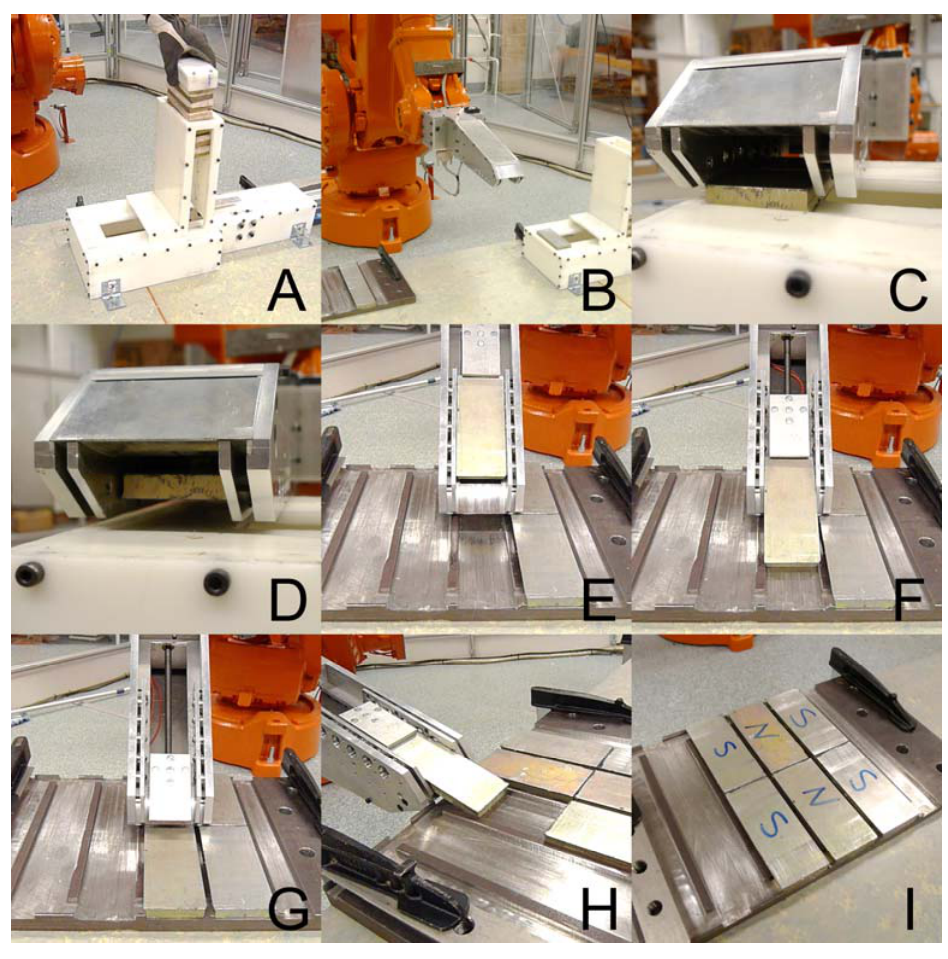
Figure 7. The full assembly process performed with the prototype robot cell: the PM delivery station is manually loaded ( A ); the PM mounting robot tool is turned upside down ( B ); a PM is picked up into the tool ( C , D ); and six PMs are mounted on the PM mounting frame ( E – I